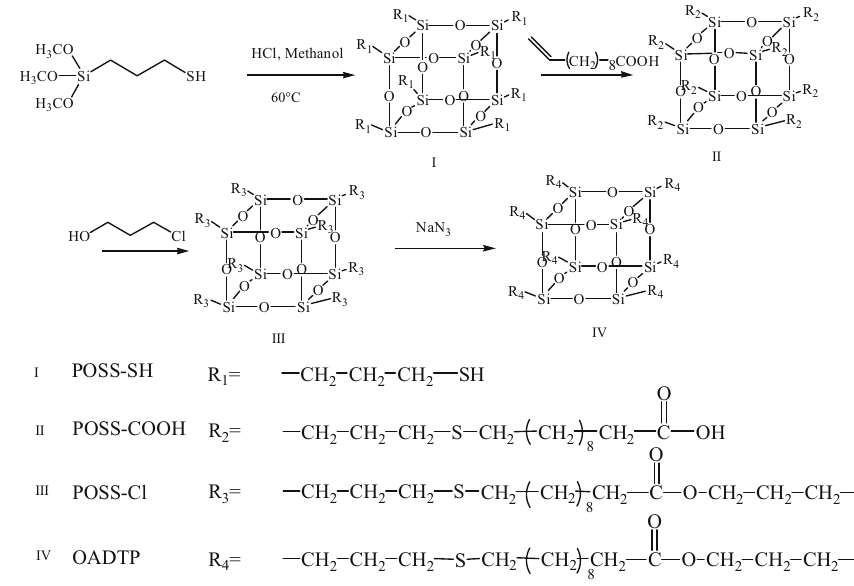
Figure 1: Synthesis of octakis ( azidopropyl - 3 - oxycarbonyl - 1 - decyl - 10 - thiopropyl - 3 -) POSS ( OADTP )